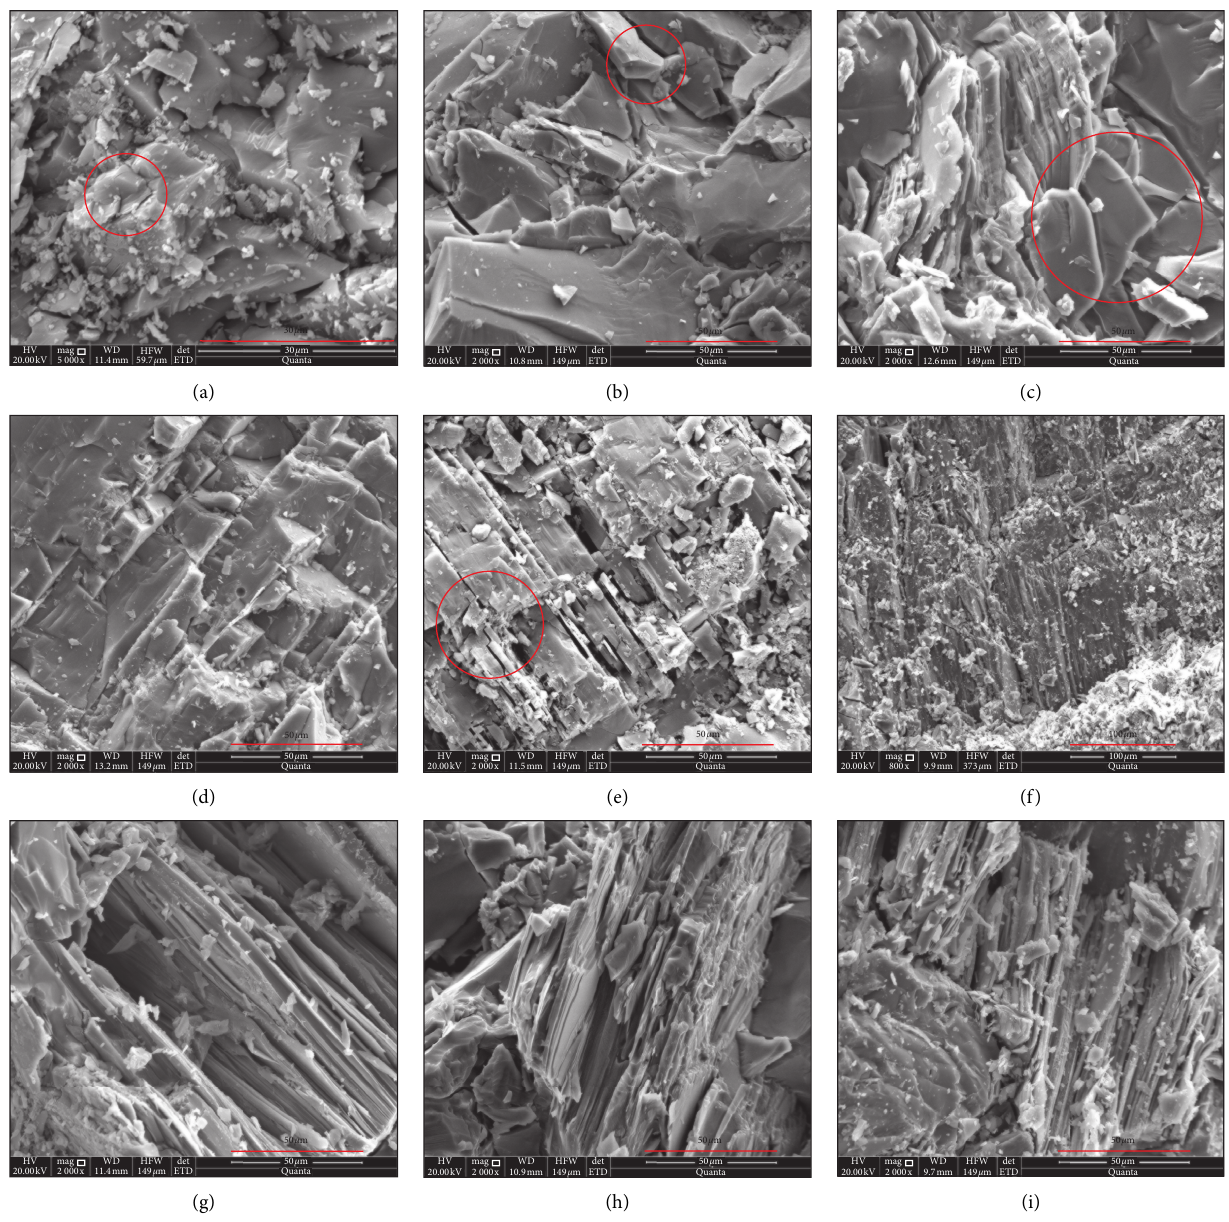
Figure 7: SEM images of failure surface of the posttest granite specimens. (a–c) Cracks in quartz under different fluid injection and temperature conditions. (d–e) Shear failure of feldspar under different fluid injection and temperature conditions. (g–i) Shear failure of biotite under different fluid injection and temperature conditions. The cracks are circled in